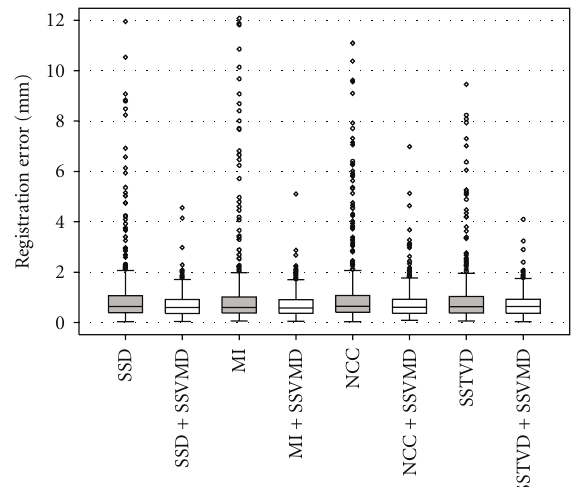
Figure 6: Box plot of landmark errors for six subjects after using eight registration methods. Results from methods with SSD, MI, NCC, and SSTVD metric along contain outliers beyond the error range.